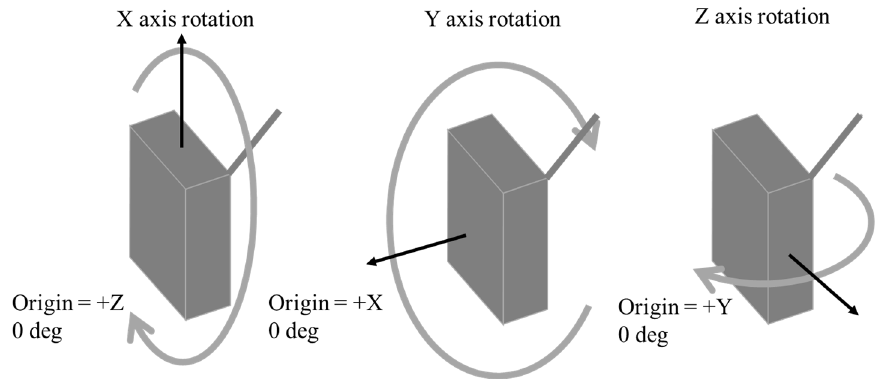
Figure 9. Satellite rotation configuration for three axes radiation pattern measurement.